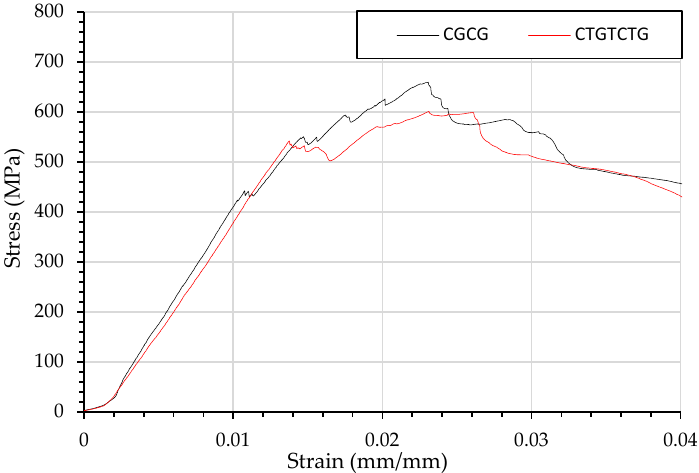
Figure 9. Flexural testing using three-point bending of composites beams and resulting stress strain curve of stress strain curve of CGCG and CTGTCTG.